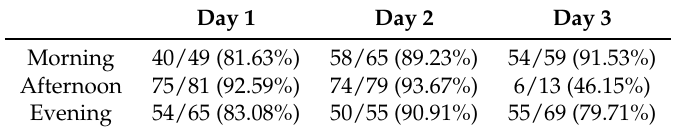
Table 6. Revisited accuracy of our solution for each day and segment of the testing